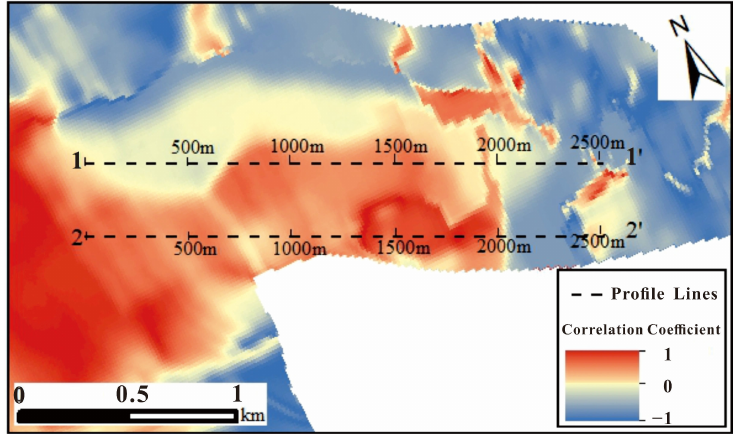
Figure 16. Correlation coefficients within the significant deformation